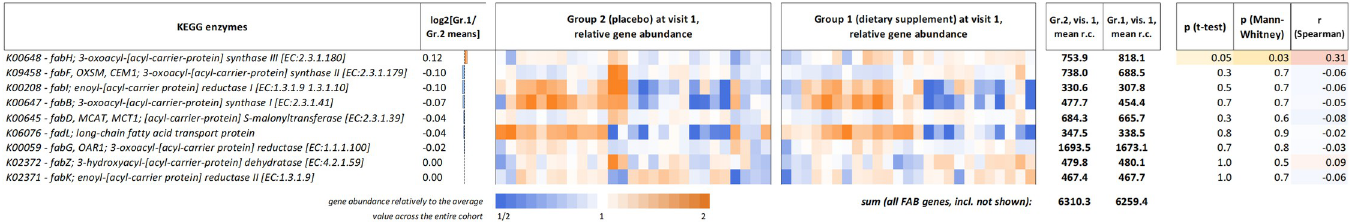
Fig 4. Relative content in the metagenome of genes involved in fatty acid biosynthesis (FAB) in patients of groups 1 and 2 at visit 1 (inferred from taxonomic data). Columns 5 and 6 show the average content of FAB genes in each group. The heatmaps in columns 3 and 4 demonstrate the relative gene abundance per sample. Samples are re-arranged according to the similarity of gene abundance profiles.